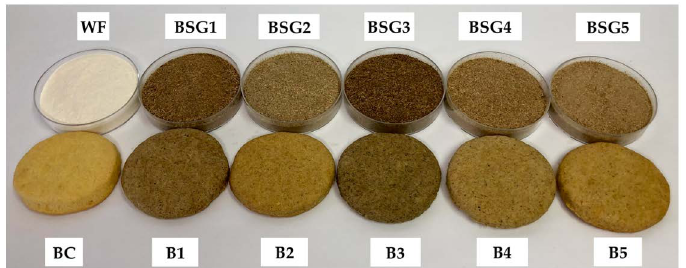
Figure 1. WF (wheat flour) and BSG (brewers spent grains) samples with their corresponding final baked cookies; BC—cookie sample manufactured with 100% WF; B1—cookie sample manufactured with 20% BSG1; B2—cookie sample manufactured with 20% BSG2; B3—cookie sample manufactured with 20% BSG3; B4—cookie sample manufactured with 20% BSG4; B5—cookie sample manufactured with 20%